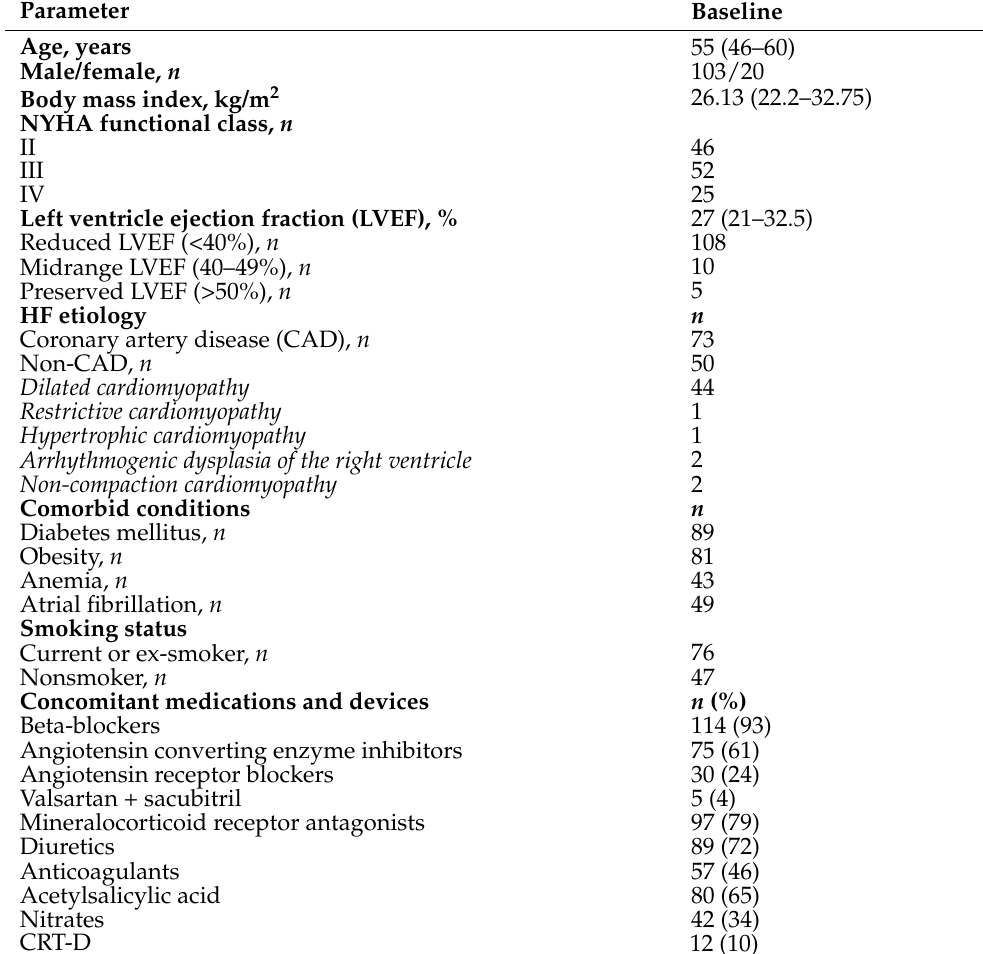
Table 1. Baseline characteristics of the